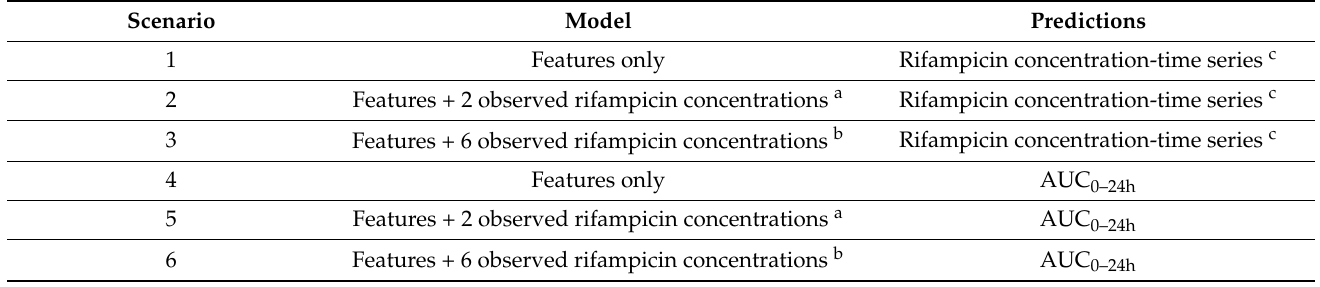
Table 2. Different scenarios of data sizes used for model training and predicted